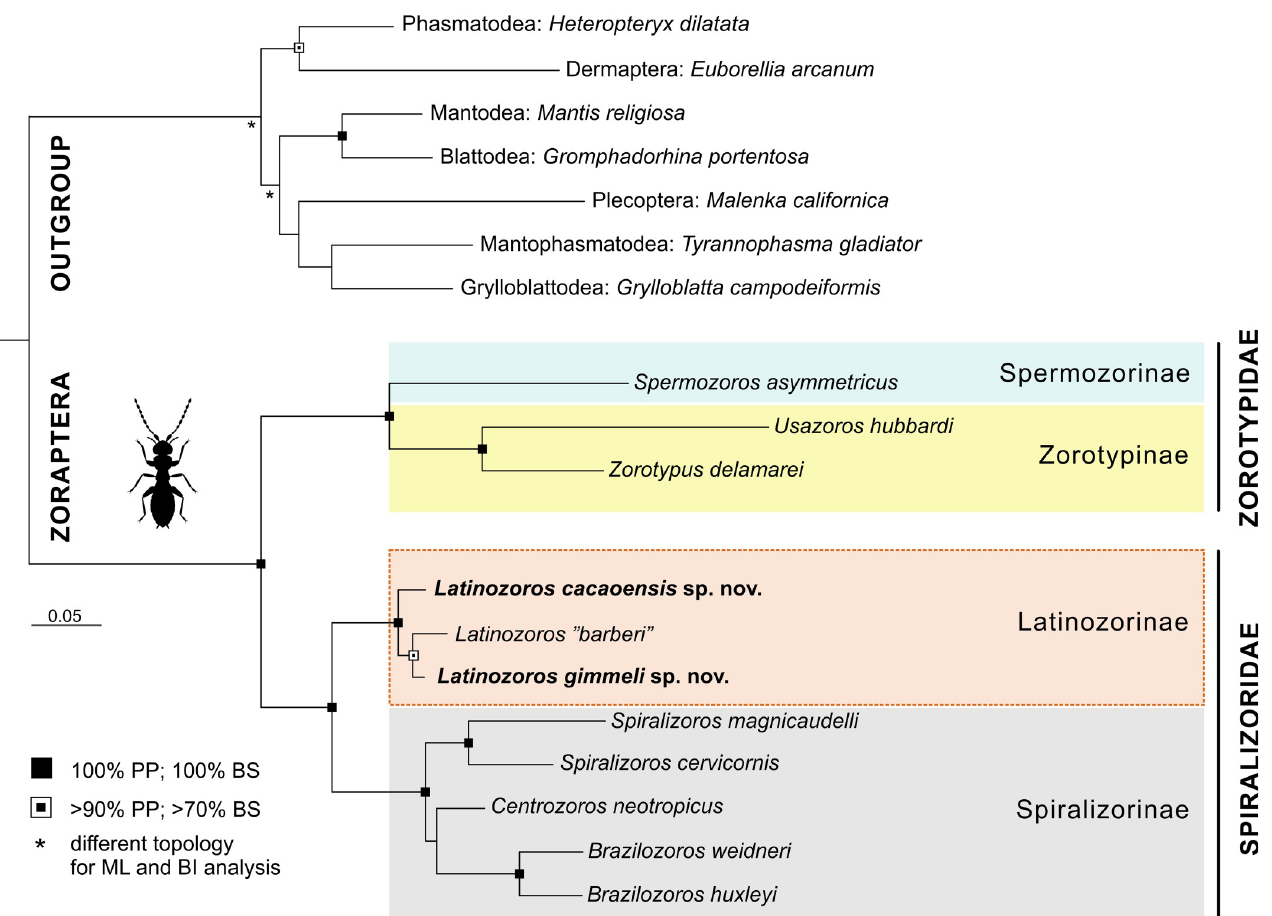
Fig 9. Phylogenetic tree of Zoraptera resolved by Bayesian inference based on the combined dataset for three molecular markers (18S, H3, and 16S). Bayesian posterior probabilities (PP) and RAxML bootstrap supports (BS) are expressed. For species in quotation marks, see Materials and Methods.